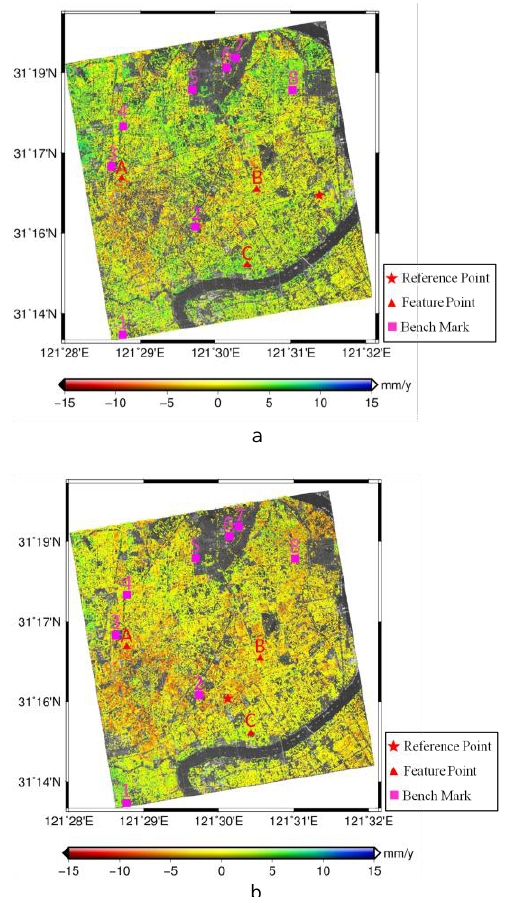
Figure 10. Average subsidence rate of interested area （ a. Deformation rate obtained by the Improved PS detection method. b. Deformation rate obtained by the Dual Threshold method ）